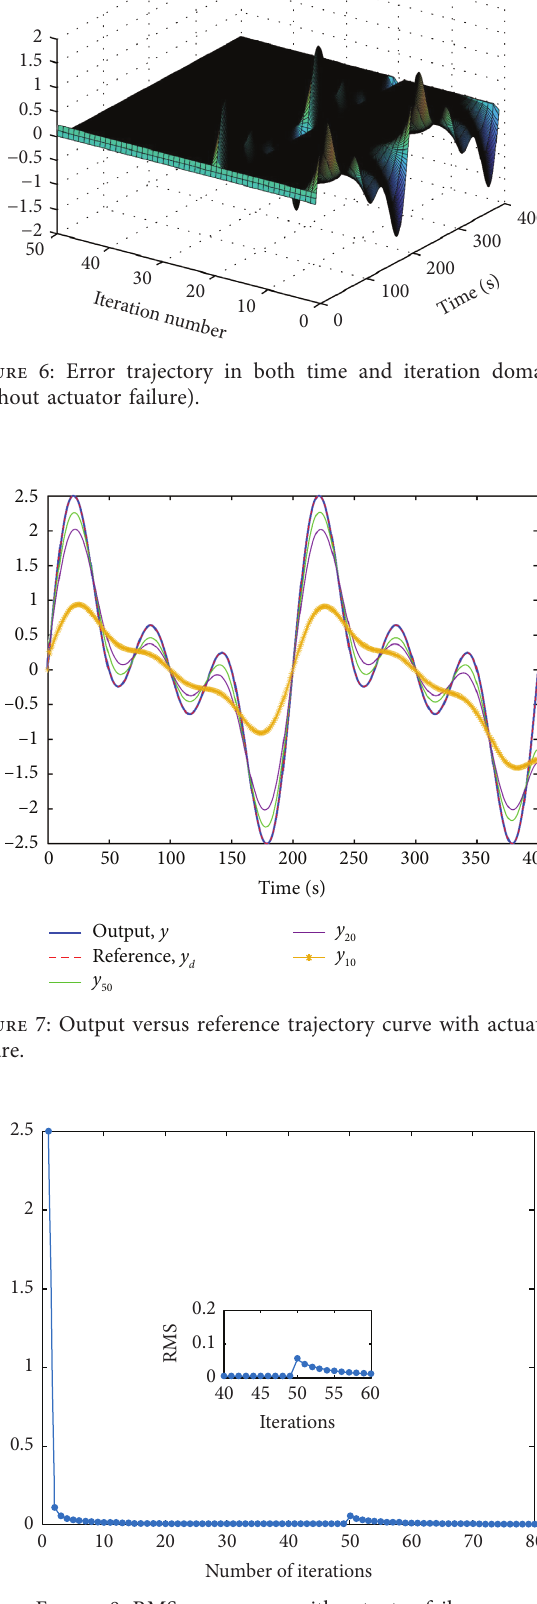
Figure 8: RMS error curve with actuator